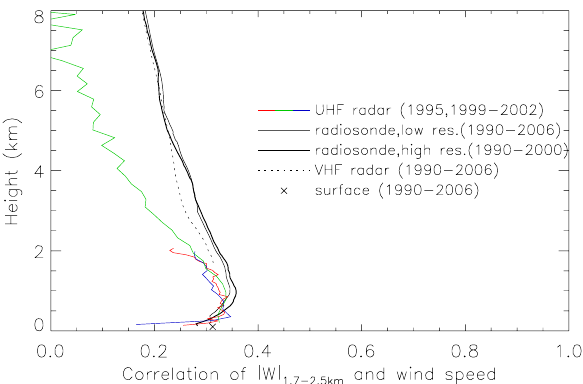
Fig. 9. Correlation of | W | at 1.7–2.5km with: horizontal wind from radiosondes, VHF radar, UHF radar in 3 modes (green line: 192–193m height resolution, February–March 1995 and Novem- ber 1999–March 2002; red line: 55m, November 1999–May 2001; blue line: 96m, May 2001–March 2002), and average of up to 26 surface sites in Fig.